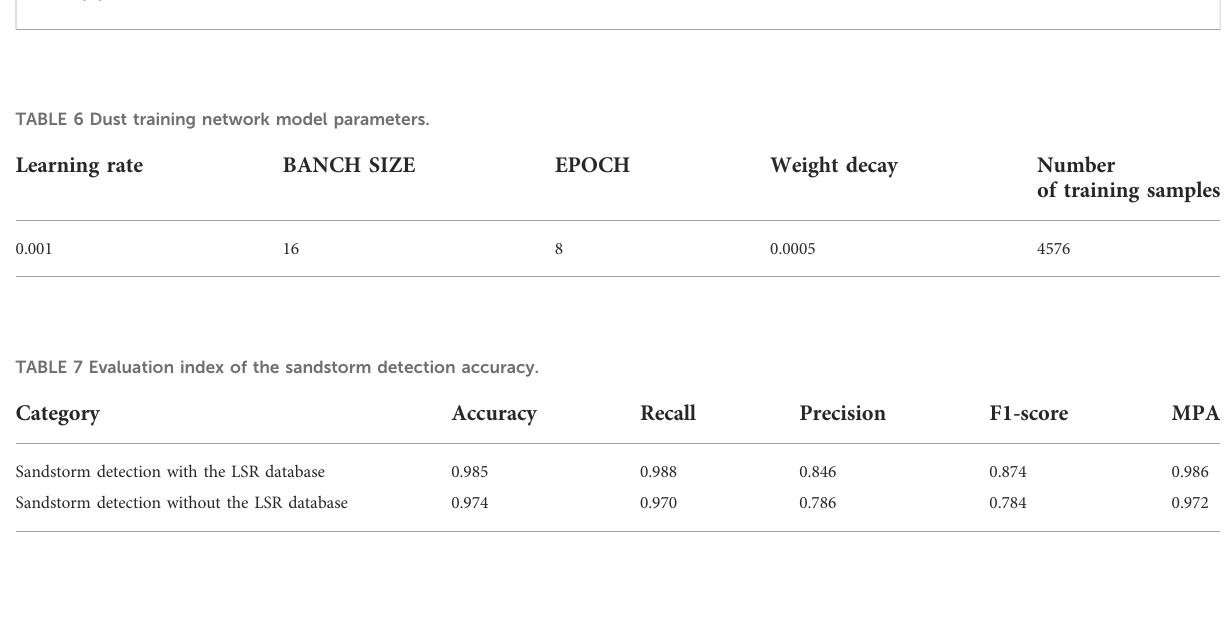
FIGURE 11 Comparison ofsandstorm detection results incloud/bare landtheregion on 28March2021.Spatialdistributions ofMODIS image(band:1-4-3) (A) , OMI AI product (B) , detection results of space sandstorms with LSR (C) , and detection results of space sandstorms in MODIS images without LSR (D) .